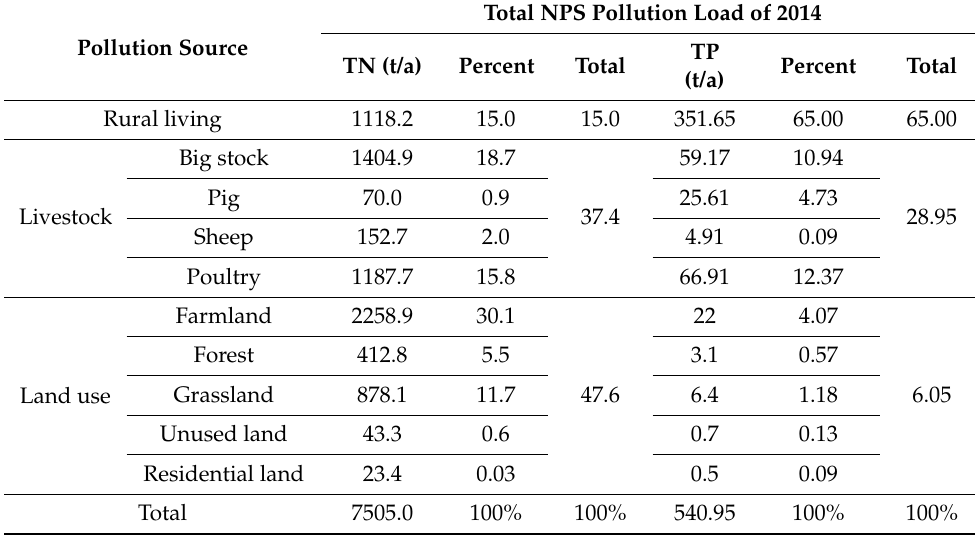
Figure 5. Spatial distribution of path-through rate for the NPS pollution of field and town scales. Table 3. NPS pollution load from various sources in